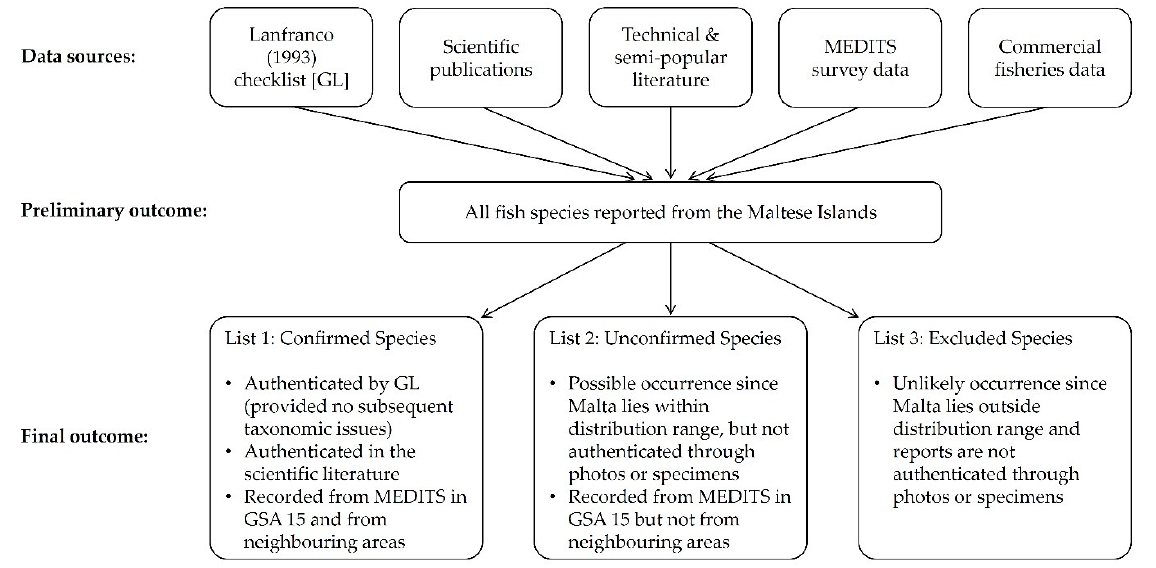
Figure 2. Schematic figure detailing the process used to compile the critical checklist of marine fishes recorded from Maltese waters.